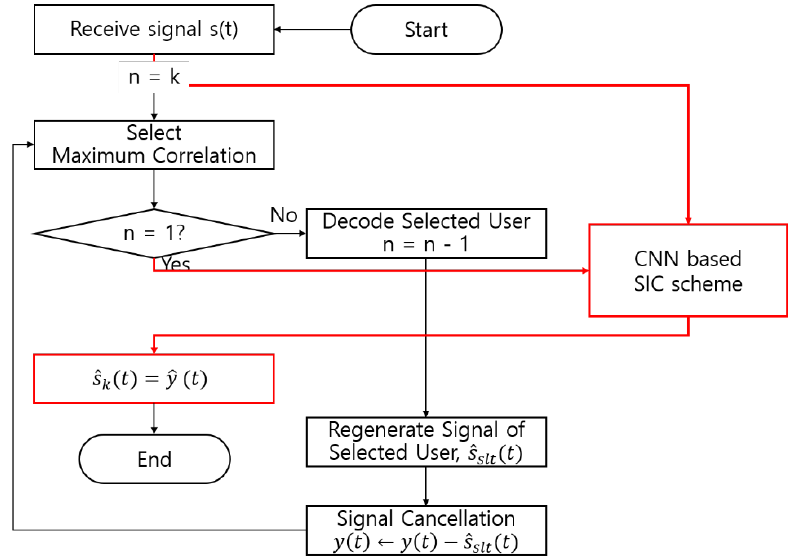
Figure 4. The proposed convolutional neural network (CNN)-based SIC scheme.